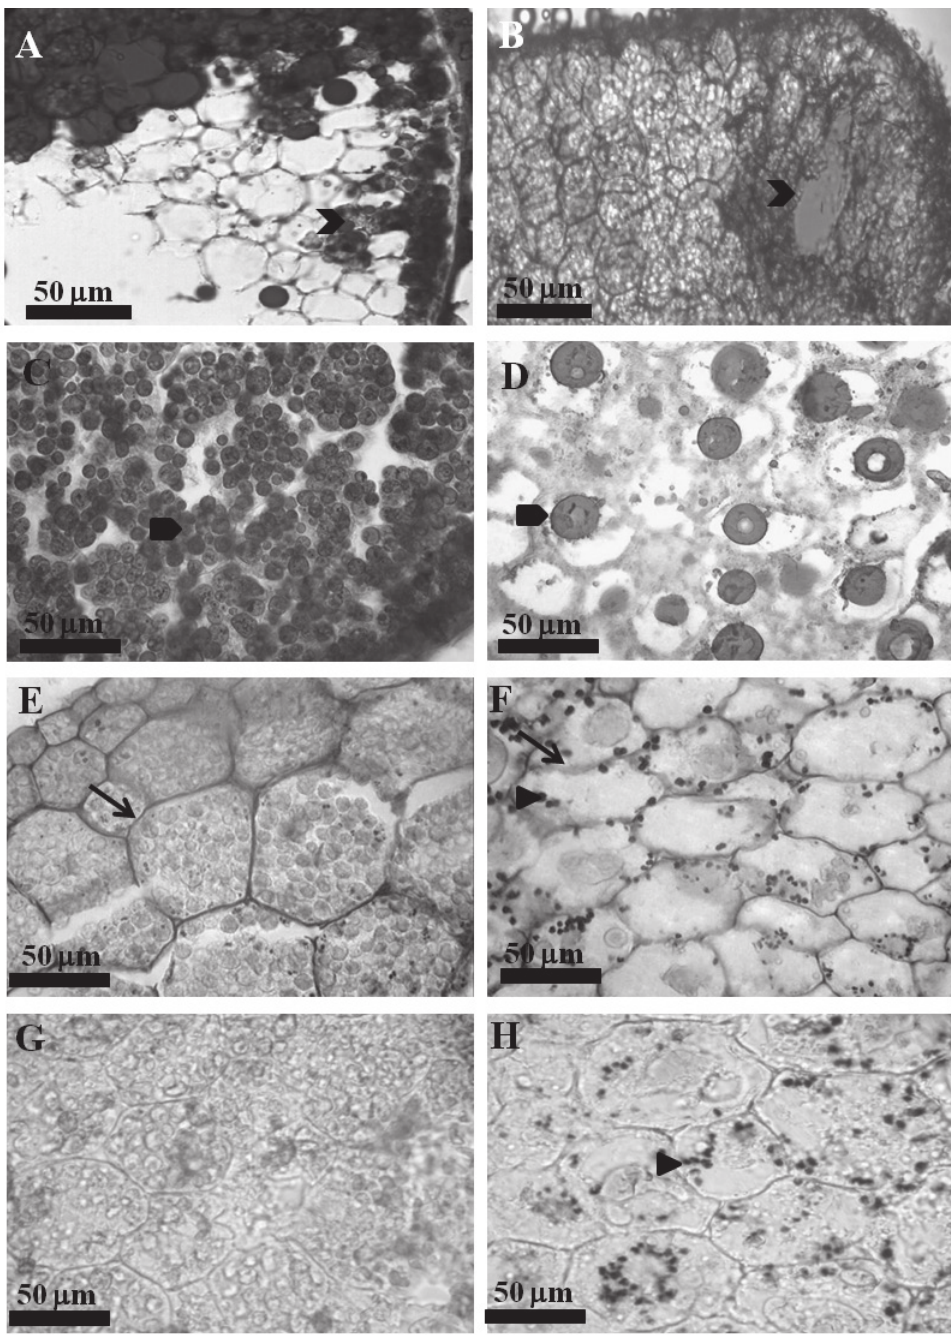
Fig. 2 - Cotyledon cross sections at 0 (A) and 6 days after imbibition (DAI) (B), showing lipid bodies ( ) stained by Sudan IV, protein bodies ( ) at 0 (C) and 6 DAI (D) stained by xylidine Ponceau. Sections at 0 (E) and 6 DAI (F) showing cell-wall ( ) and PAS-positive reactions indicating starch grains ( , F). Sections at 0 (G) and 6 DAI (H) stained by lugol, confi rming starch grains ( , H